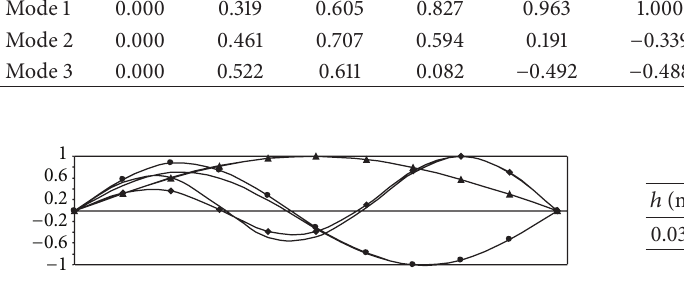
Table 10: Optimal frequencies and MRQA